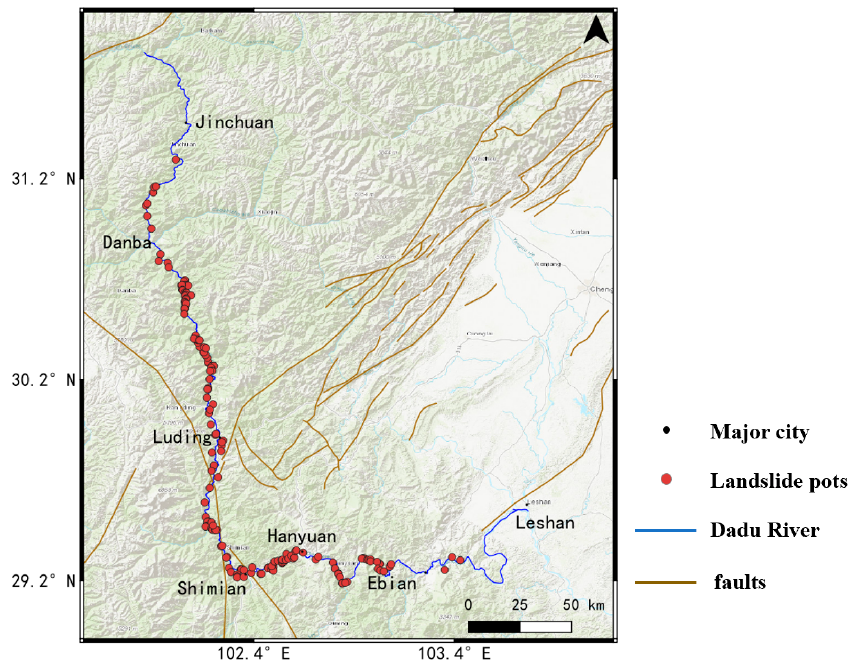
Figure 11. The distribution of landslides (red dot) along the Dadu River detected using InSAR results. The yellow lines are the geological faults in the Dadu River Basin.